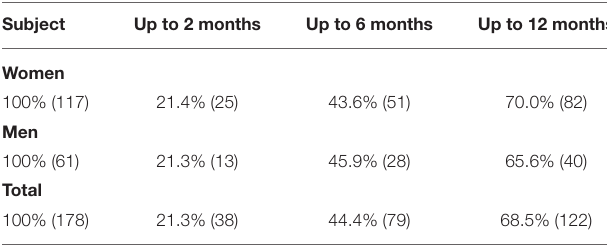
TABLE 3 | Dropout rate at 2, 6, and 12 months. TABLE 4 | Dropout rate at 2, 6, and 12 months in patients with psychiatric